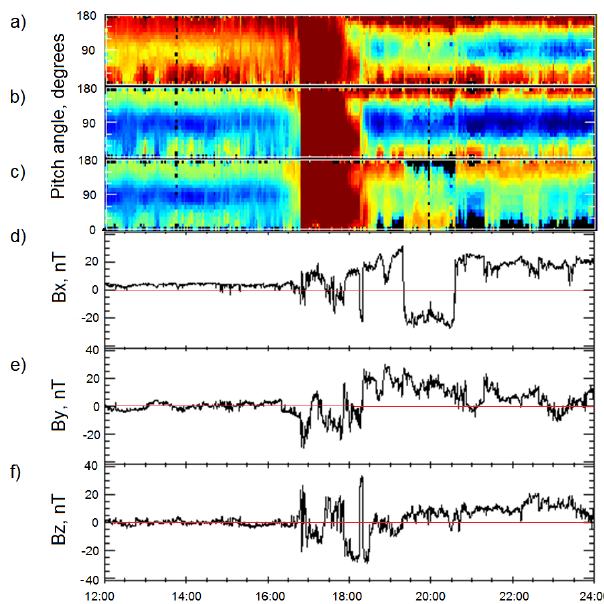
Figure 5. Suprathermal electron pitch angle spectrograms at differ- ent energies (a–c) compared with three components of the IMF (d– f) during the 21 January 2005 event. (a) 519eV flux, (b) 142eV flux, (c) 73.3eV flux, (d, e) in-ecliptic components of the IMF, (f) the vertical component of the IMF in GSE.